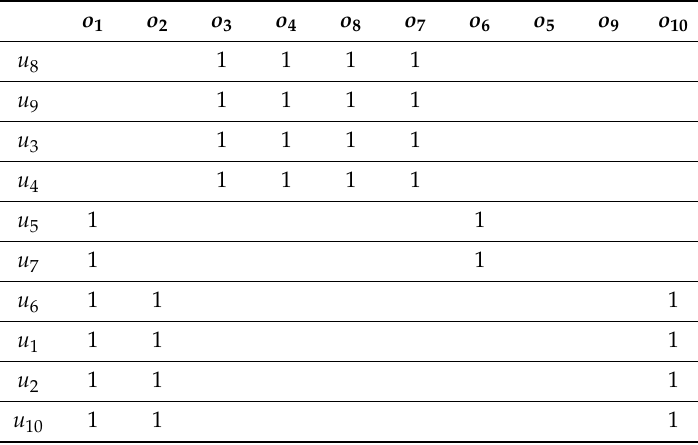
Table 9. Step 2 for